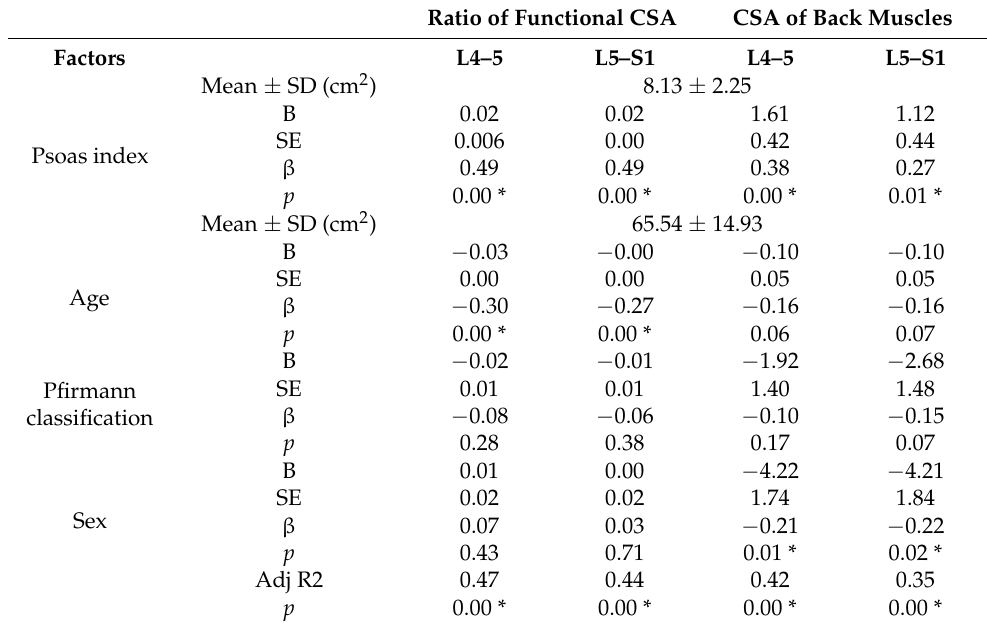
Table 2. Multivariant regression analysis of psoas index, age, Pfirrmann classification, and sex according to the ratio of functional CSA and CSA of back muscles.